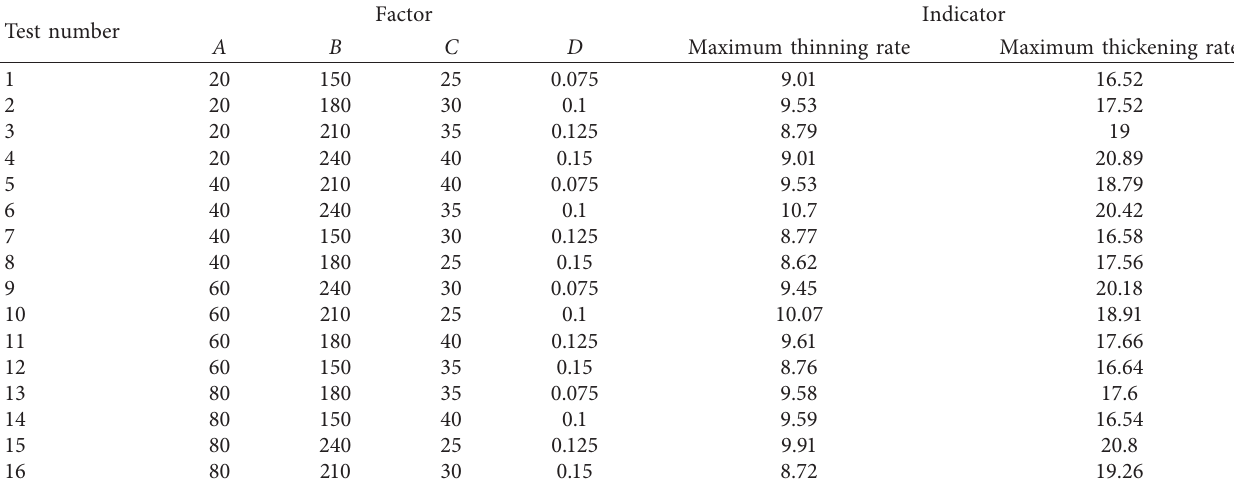
Table 3: Experimental design and results.